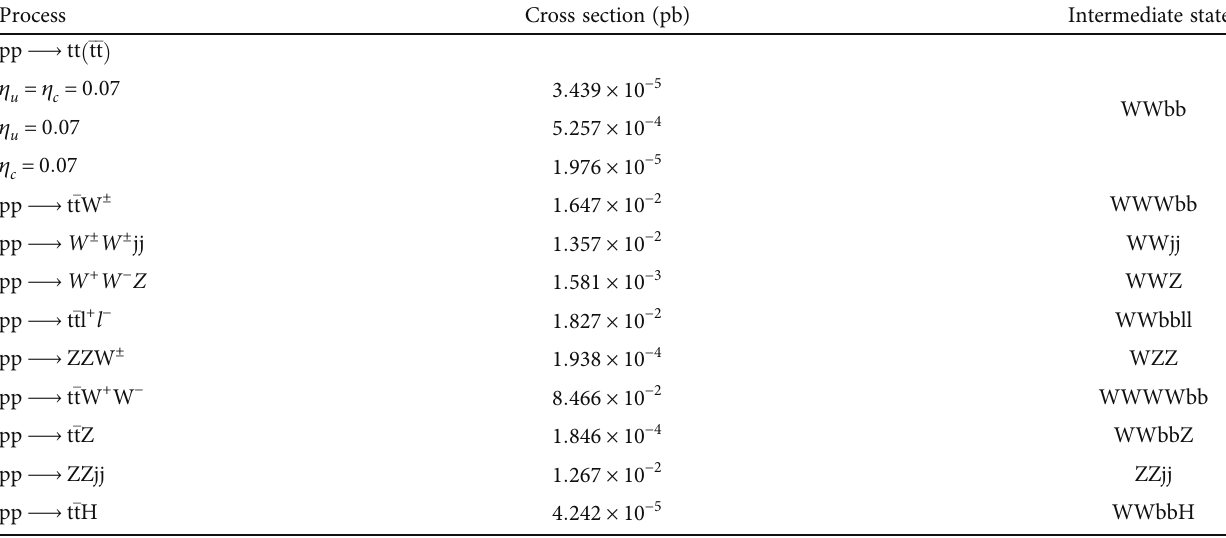
Table 2: Signal and background processes with leptonic decay channels: We consider the positively and negatively charged leptonic fi nal states for maximal imitation of signal process. So background events generated with this regard, we force particles to give l + / l − fi nal states if possible. Otherwise, we let particles to decay any channel. For W boson at intermediate states, we always take leptonic decay modes in getting the maximal similarity with signal.